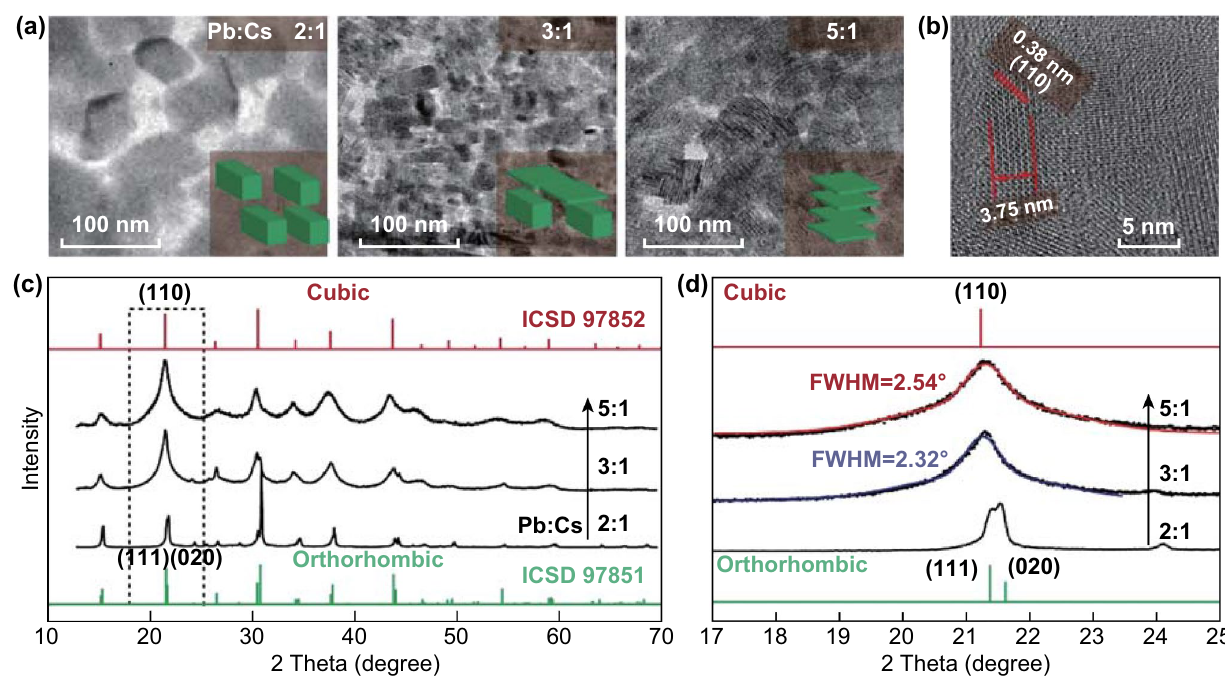
Fig. 2 Phase engineering of CsPbBr 3 NCs through feeding varied molar ratios of Pb/Cs. a TEM images showing morphology transformation from bulk cubes to thin nanosheets. b High-resolution TEM image of nanosheets (Pb/Cs = 5/1). c XRD patterns showing a phase evolution from orthorhombic to cubic. d The magnified XRD peaks show a clear difference in peak width, indicating a shrinkage of grain size